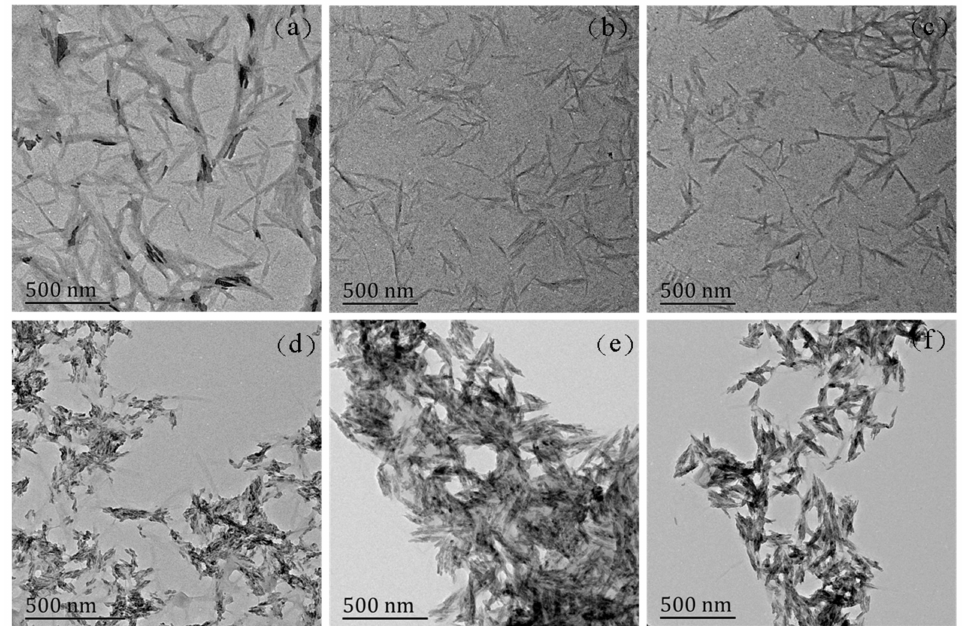
Figure 2. Transmission Electron Microscope (TEM) micrographs of NCC ( a ), NCC / HAP50 / 50 ( b ), NCC / HAP40 / 60 ( c ), NCC / HAP30 / 70 ( d ), NCC / HAP20 / 80 ( e ) and NCC / HAP10 / 90 ( f ).